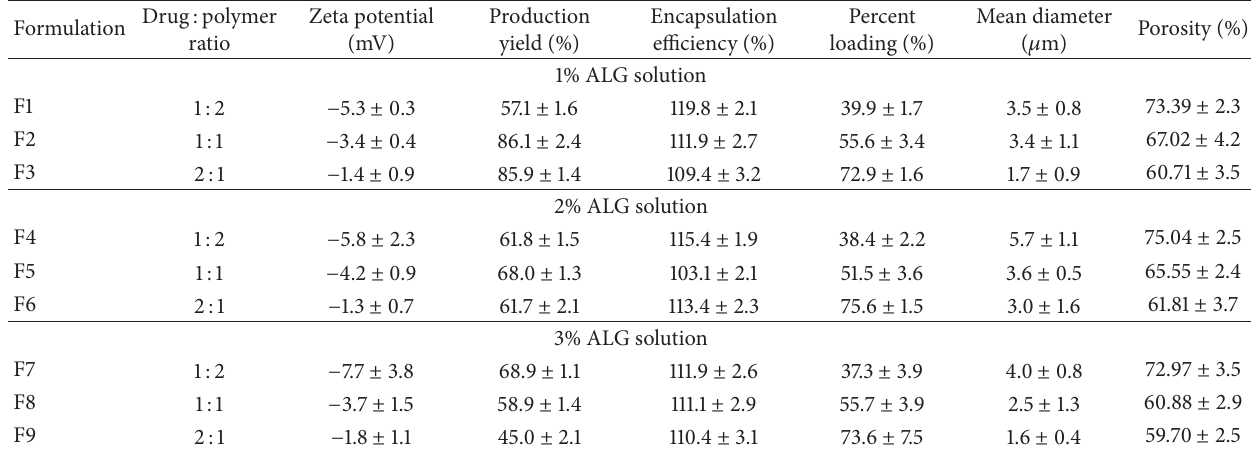
Table 1: Characteristics of MF loaded ALG microspheres (formulations F1–F9). Drug: polymer Formulation